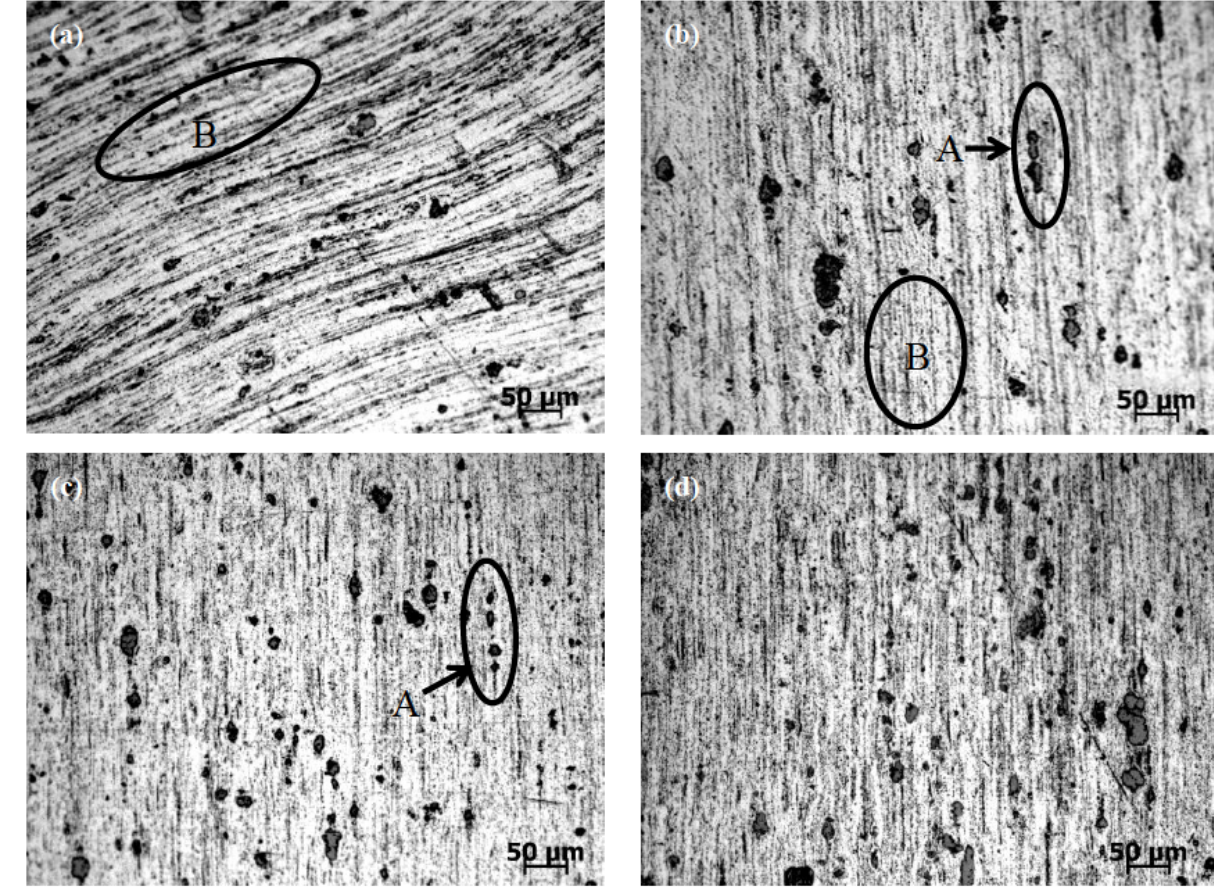
Figure 5: Vertical microstructure metallography of AgSnO 2 NiO after extrusion and drawing × 200 (a) extrusion rod diameter of 6.0 mm (b) wire drawing diameter of 5.2 mm (c) wire drawing diameter of 3.4 mm (d) wire drawing diameter of 1.5